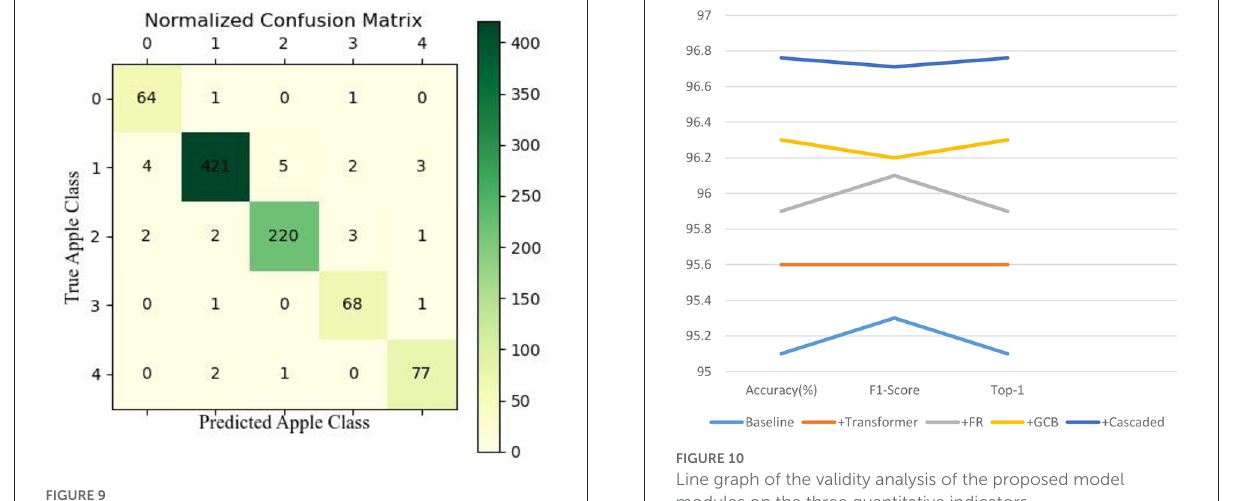
FIGURE9 Confusion matrix diagram for CBNet.